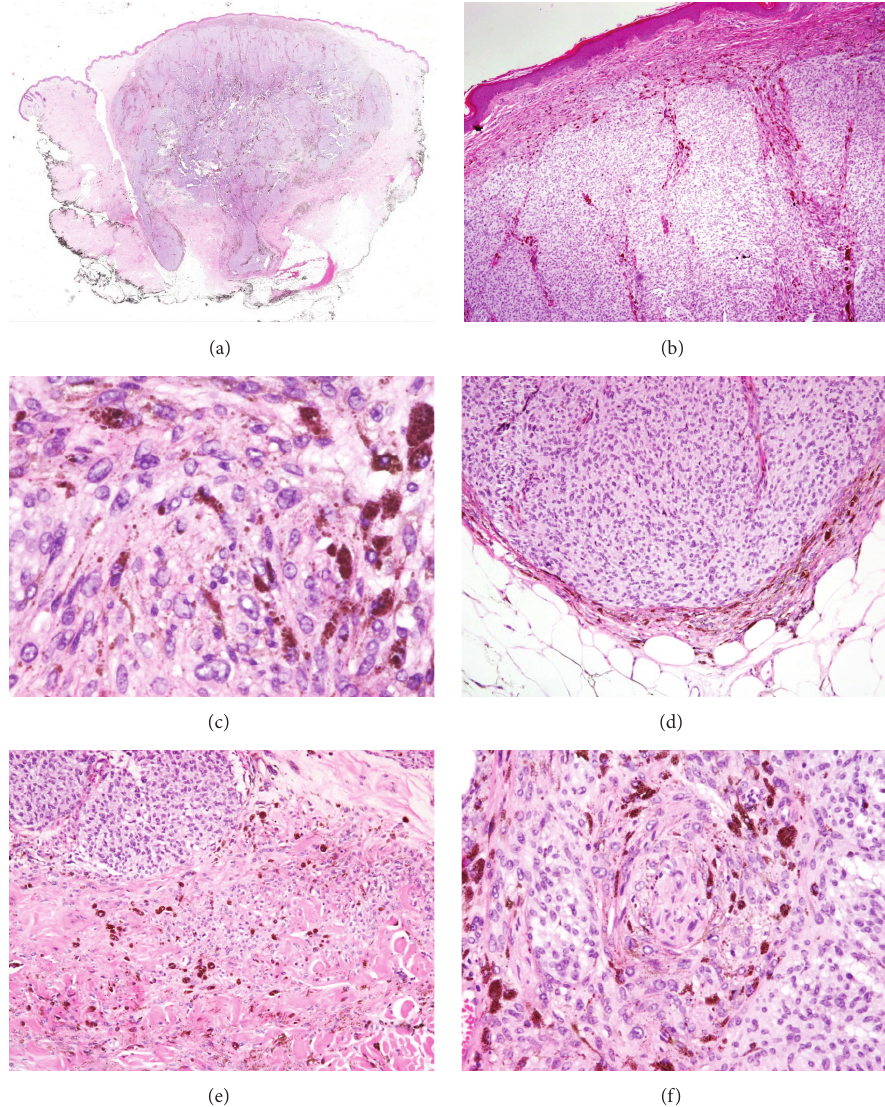
Figure 1: A pigmented lesion consisted with cellular blue nevus with an expansive pattern of extension into dermis and subcutaneous adipose tissue(a)andasparedpapillarydermis(b).Cellularislandsofcloselyaggregatedspindleshapedcellswithovoidnucleirevealedamildnuclear enlargement, a mild pleomorphism, and prominent small nucleoli (c). The deepest boundary of the tumor was a pushing border (d) with foci of more irregular infiltrative borders (e). Perineural invasion was observed